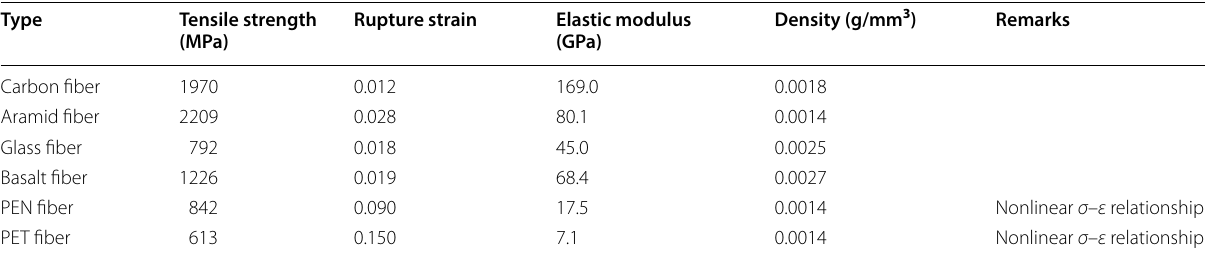
Table 1 Physical properties of various fibers.